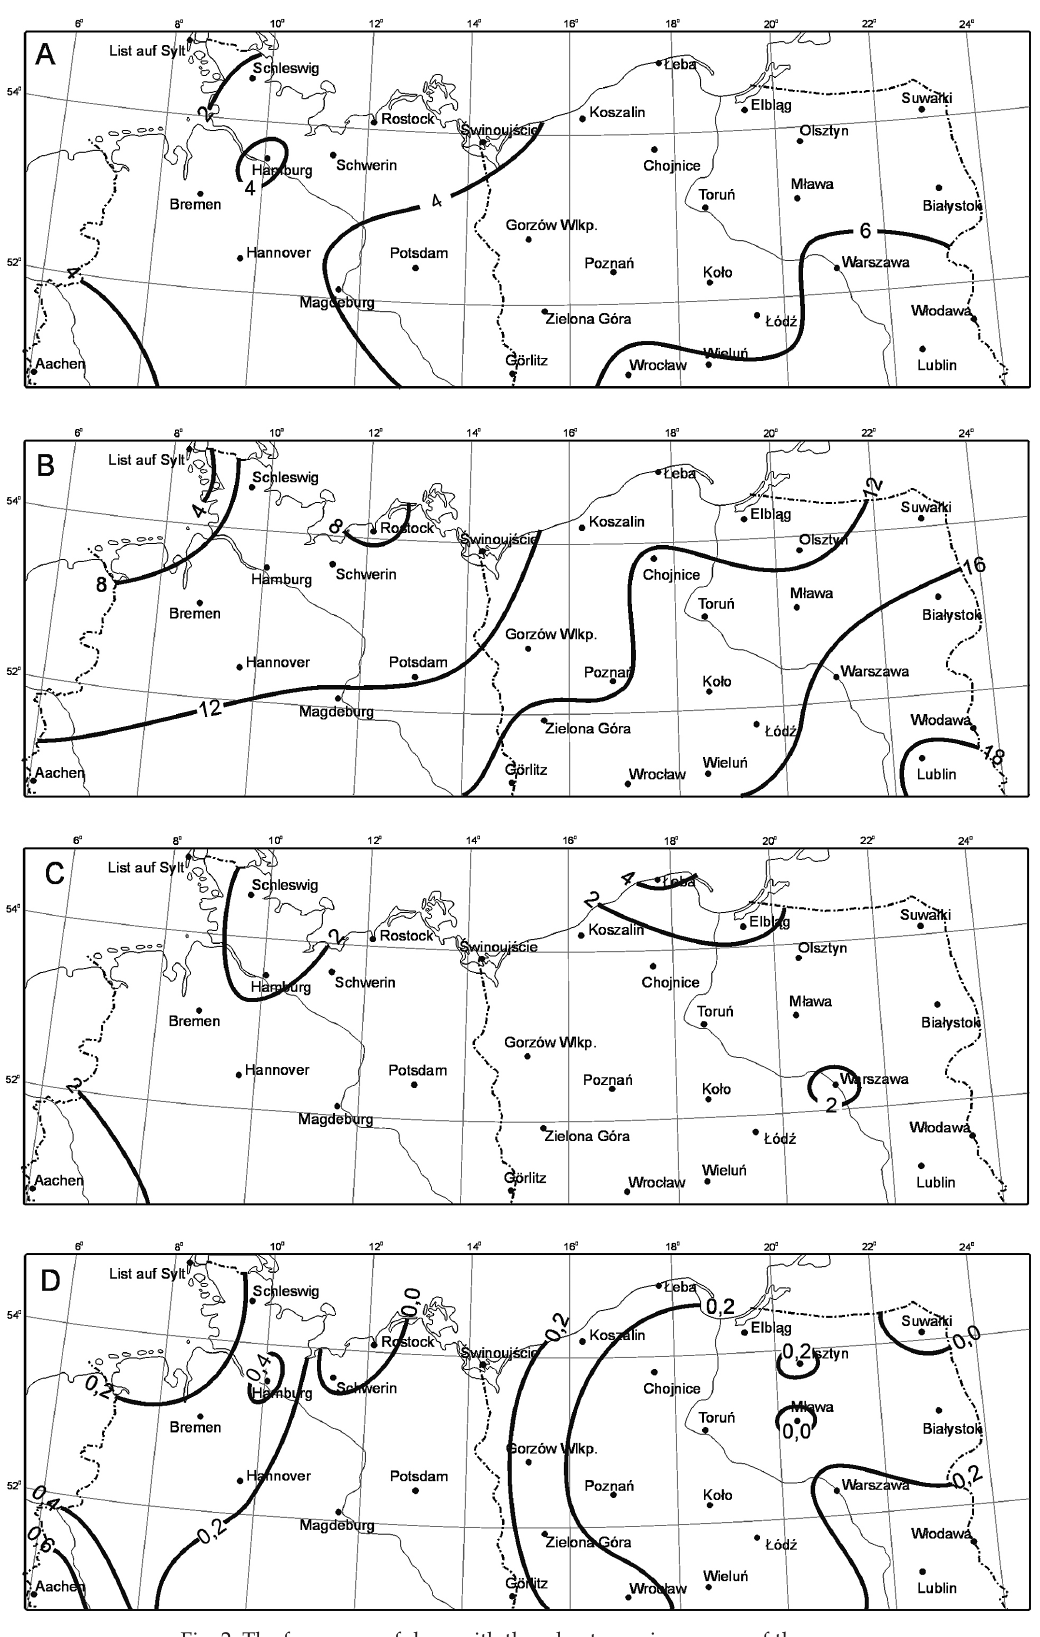
Fig. 2. The frequency of days with thunderstorms in seasons of the year. A – spring, B – summer, C – autumn, D – winter Data from the period.